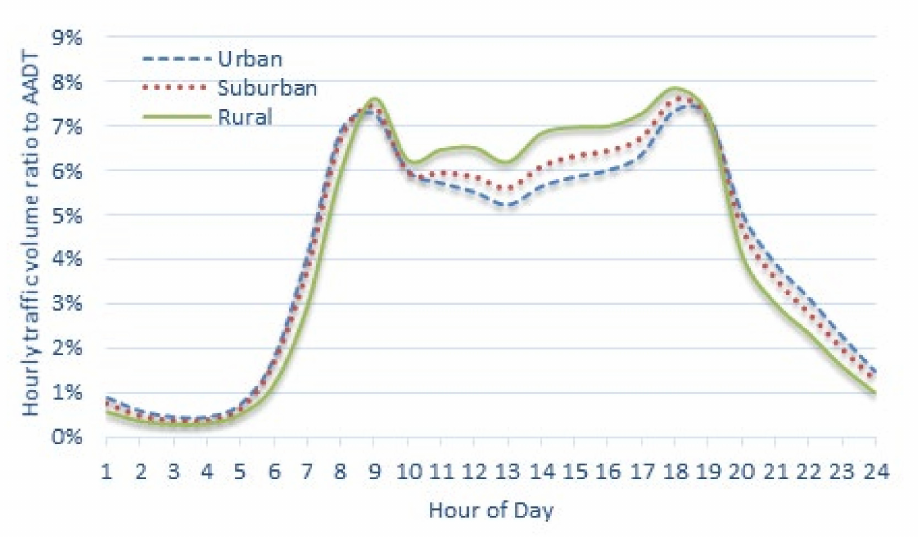
Figure 9. Annual average hourly traffic volume ratios to AADT (weekdays) of national highways of the urban, suburban, and rural areas (nationwide).